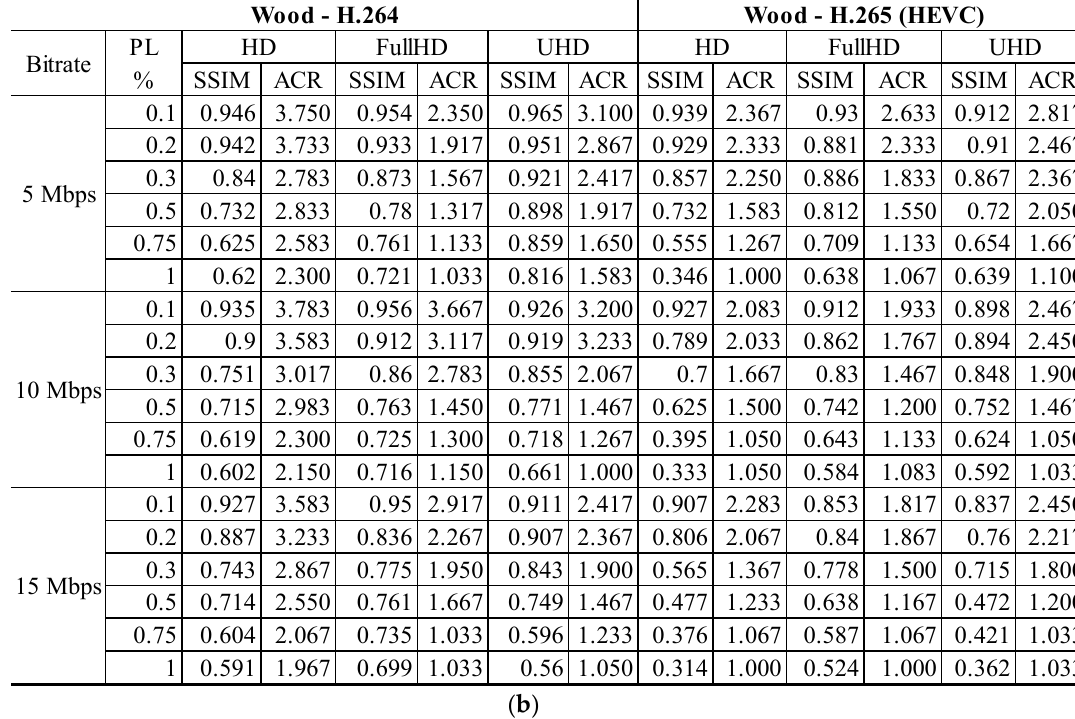
Figure 6. Subjective and objective metric results for the Runner ( a ) and Wood ( b ) scenes.